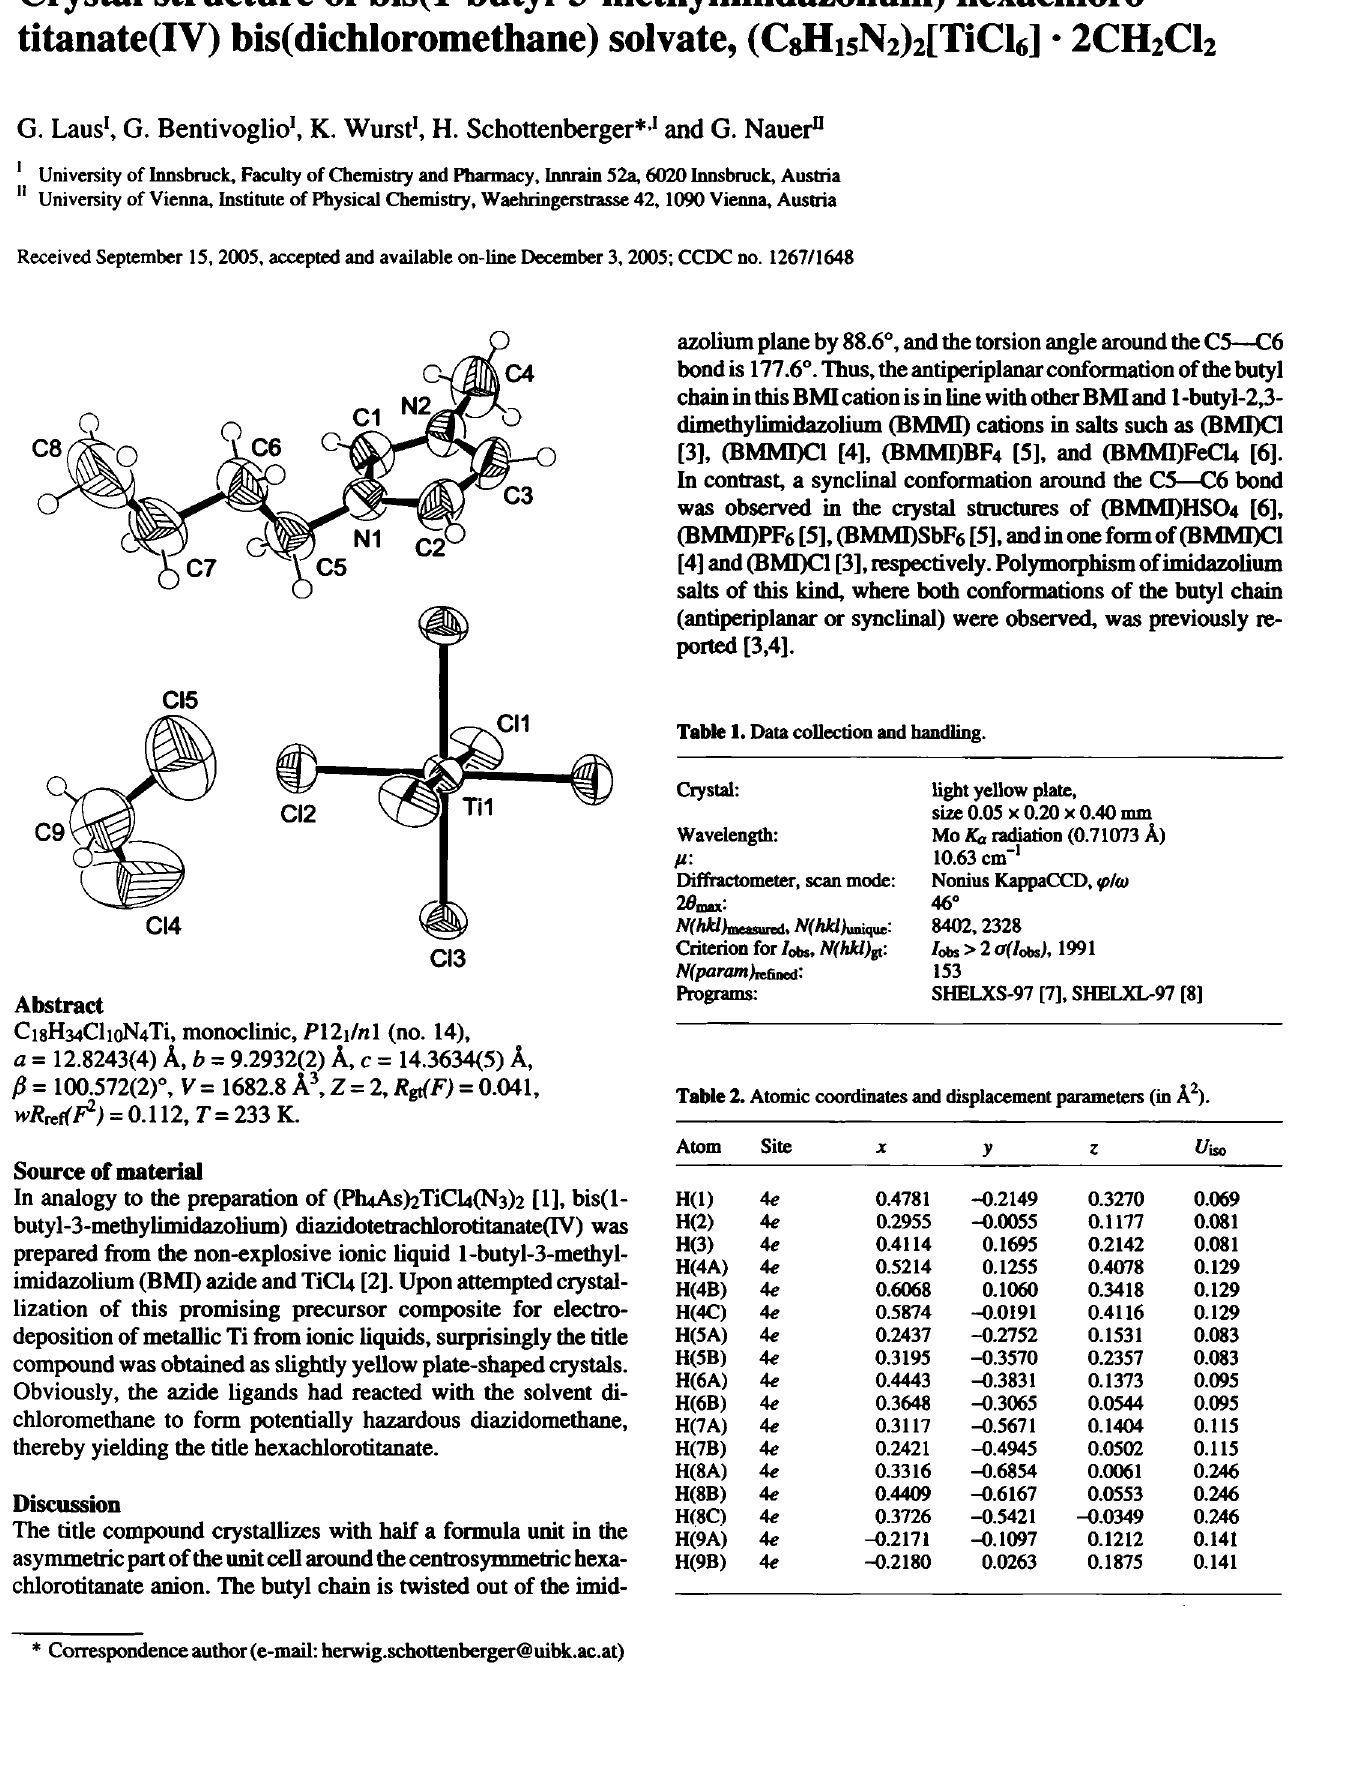
Table 2. Atomic coordinates and displacement parameters (in Ä 2